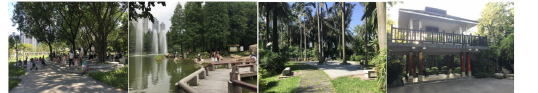
Figure A4. Recreation spaces in Zhujiang Park.